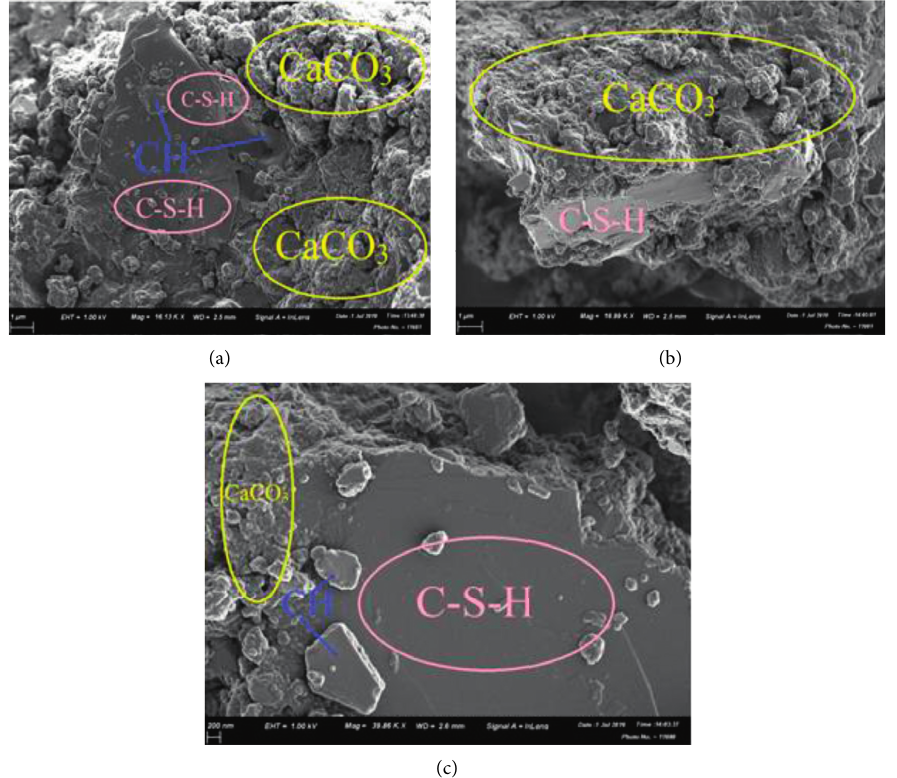
Figure 4: SEM analysis for (a) OPC-H 2 O (BM), (b) OPC-BM (H 2 O), and (c) OPC-BM